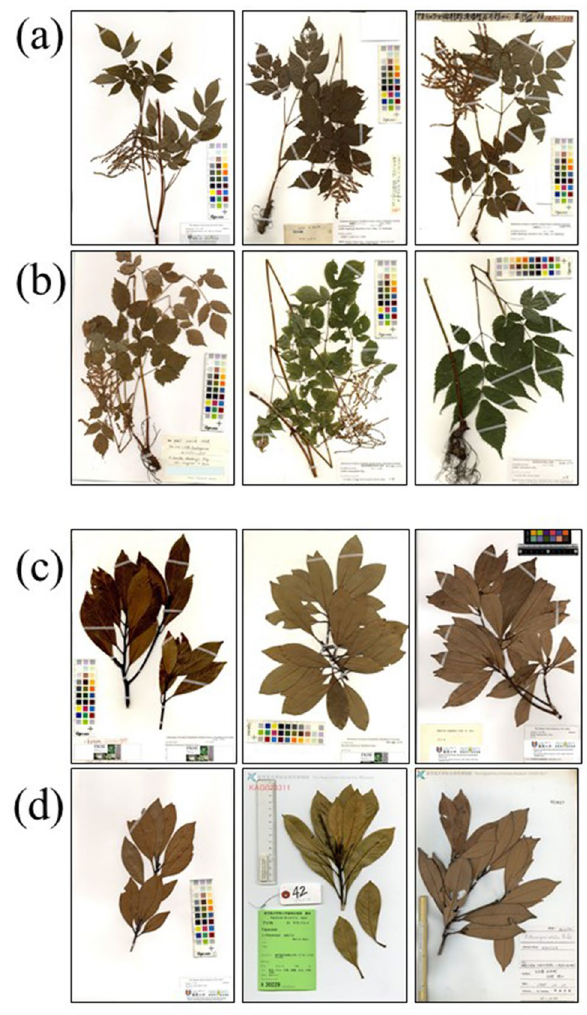
Figure 4. ( a ) Astilbe thunbergii (Siebold & Zucc.) Miq. var. thunbergii , ( b ) Astilbe odontophylla Miq., ( c ) Machilus thunbergii Siebold & Zucc., and ( d ) Lithocarpus edulis (Makino) Nakai. Species ( a ) and ( b ) and